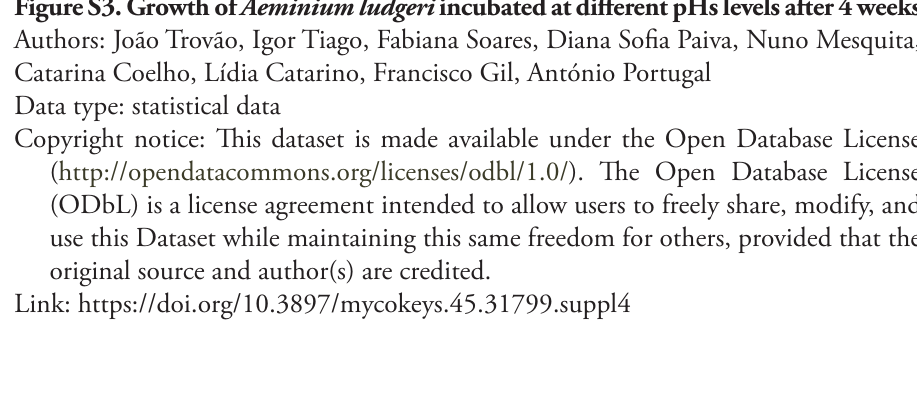
Figure S3. Growth of Aeminium ludgeri incubated at different pHs levels after 4 weeks